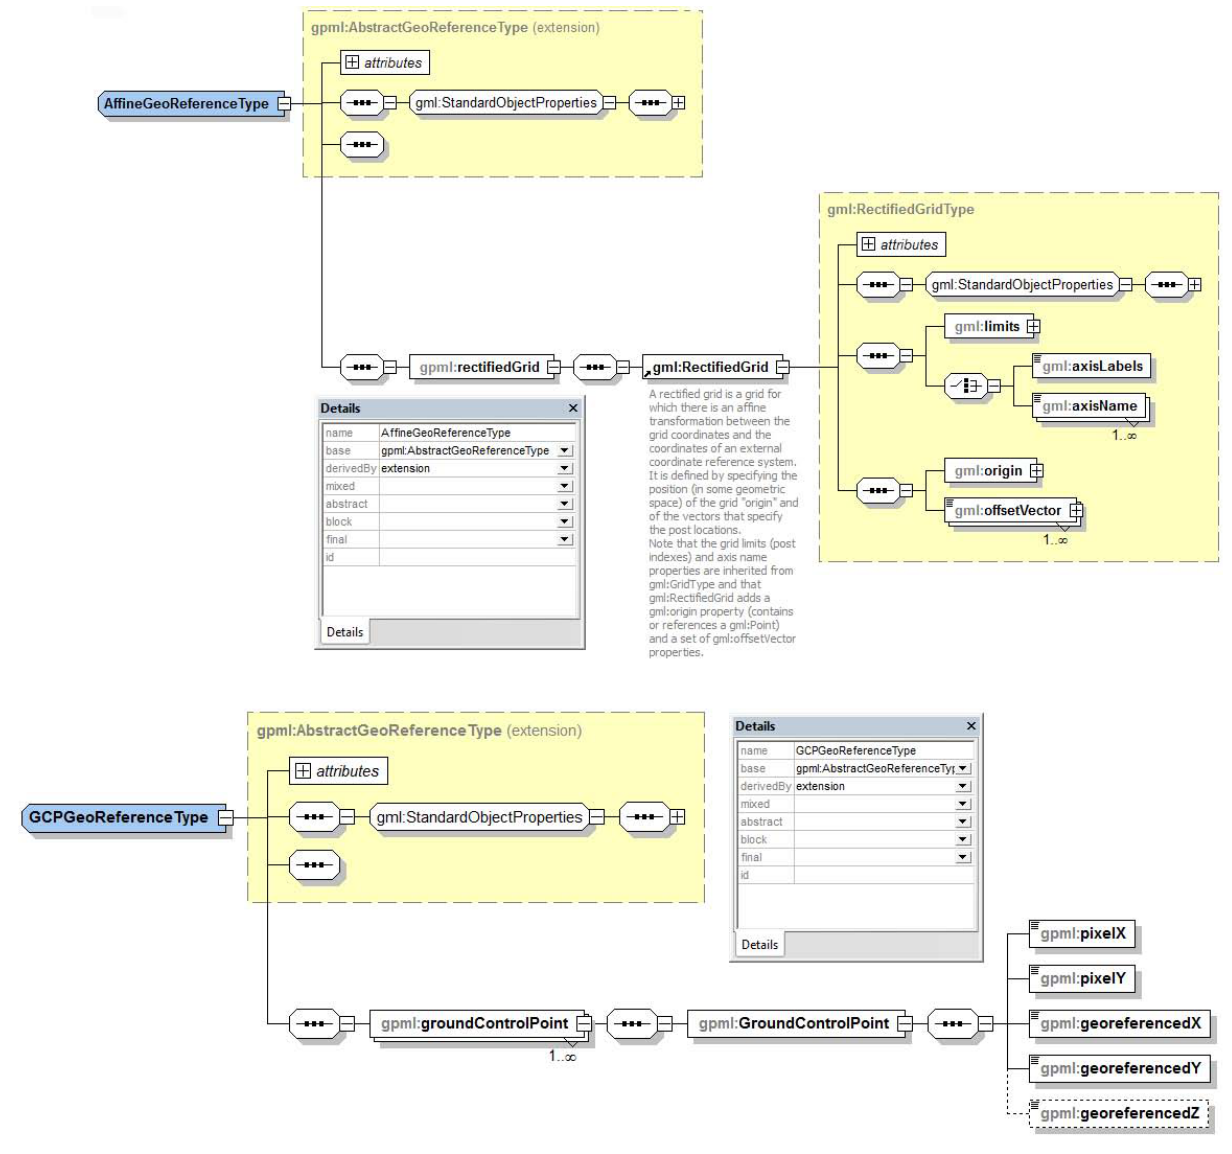
Fig. 27. Schema diagram for raster georeferencing.